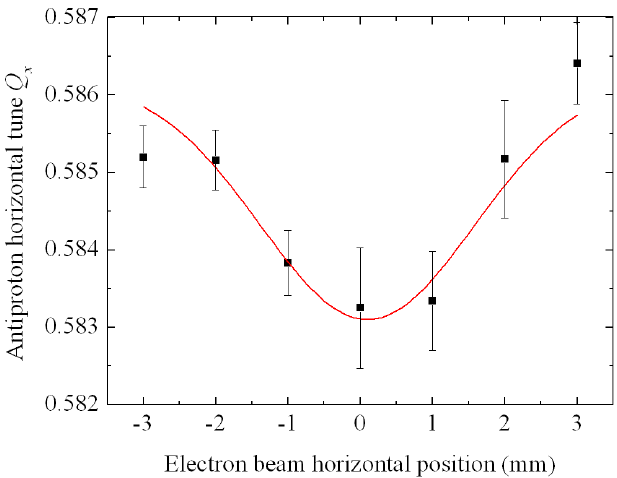
FIG. 23. (Color) Horizontal betatron tune of the 980 GeV anti- proton beam measured by the 1.7 GHz Schottky detector [24], plotted versus the electron-beam horizontal position with respect to the antiproton orbit. Gaussian electron gun. Electron rms ¼ 0 : 53 A , cathode voltage beam size 0.7 mm, current of J e ¼ 7 : 0 kV . Electrons defocus antiprotons, thus, the negative U e shift of the betatron